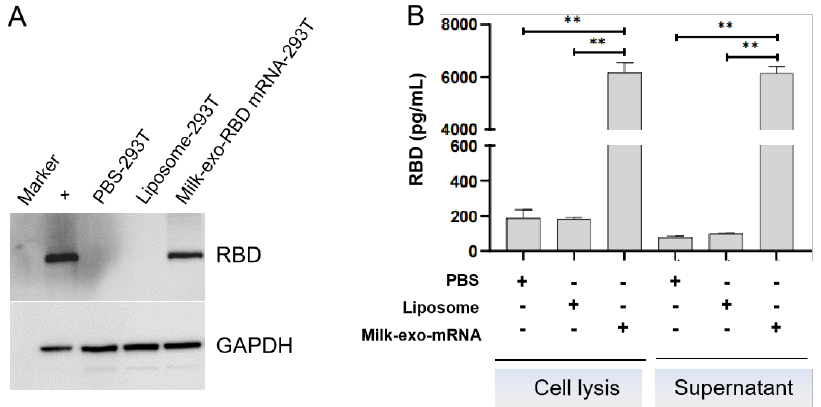
Figure 5. mRNA-loaded exosomes deliver functional SARS-CoV-2 RBD mRNA to human cells in vitro. ( A ) Western blot analysis of the expression of RBD mRNA delivered by oral vaccine in 293T cells. ( B ) The ELISA detection of RBD expressed in 293T cell lysate and secreted into the culture supernatant 24 h after the milk-derived exosome-based vaccine transfection. The data are presented as mean standard deviation with a group size of three. ** p < 0.01 vs. PBS.